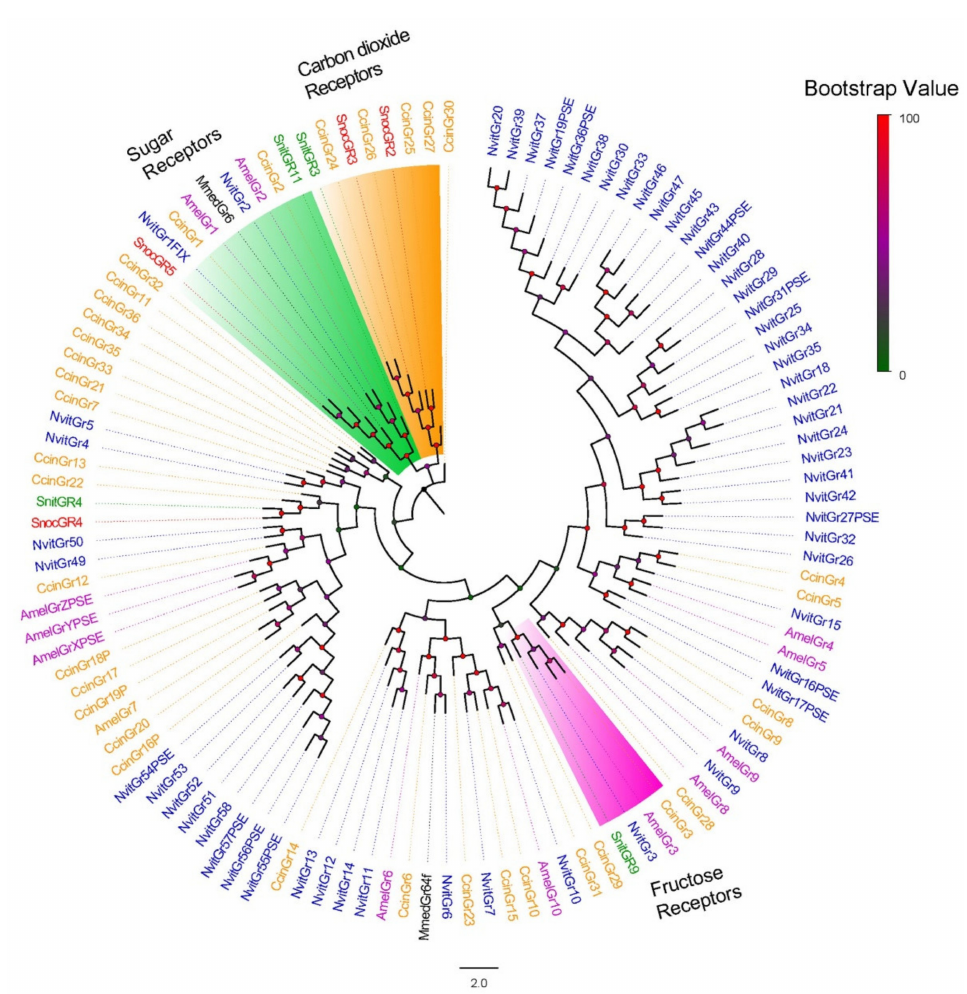
Figure 4. Phylogenetic tree of gustatory receptor (GRs). The S. noctilio genes are displayed in red and S. nitobei genes are displayed in green. Mmed: M. mediator ; Ccin: C. cinctus ; Nvit: N. vitripennis ; Amel: A. mellifera . The Amino acid sequences used for the phylogenetic tree are listed in Supplementary File